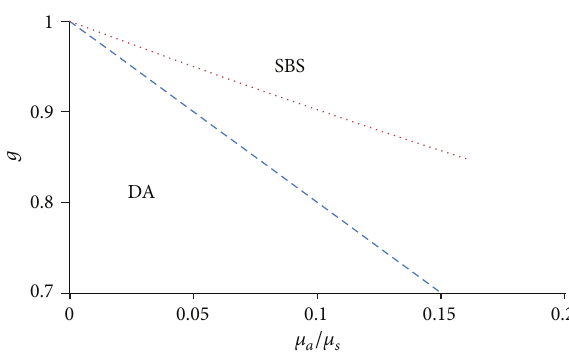
Figure 6: Areas of applicability of diffuse approximation (DA) and single backward scattering (SBS) models for biological tissues. Dashed line is 𝑎 󸀠 = 0.67 and dotted line is 𝑔 𝑚 = 0.7 (see (11) for